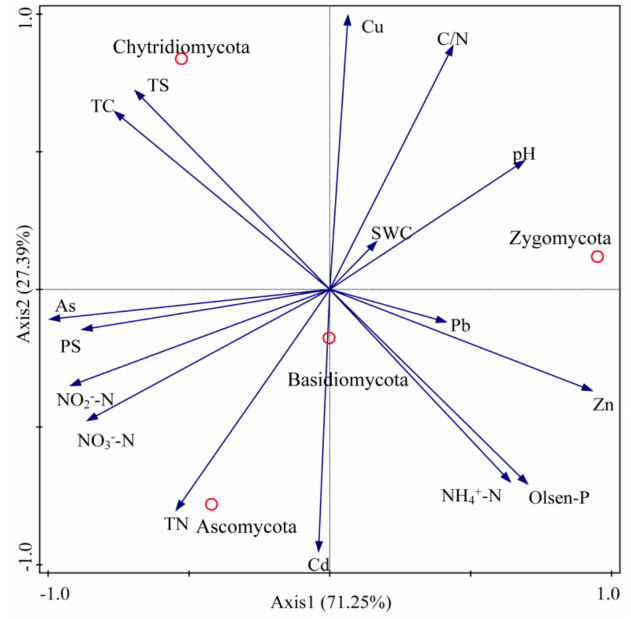
Figure 4. The Principal Component Analysis (PCA) of soil fungi at the levels of phylum and soil physicochemical properties.